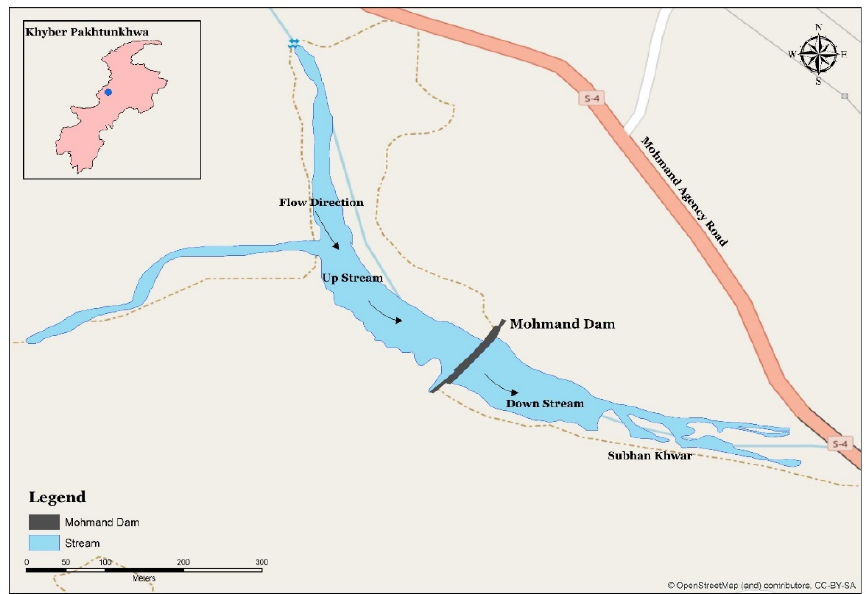
Figure 1. Location of Mohmand Dam project.